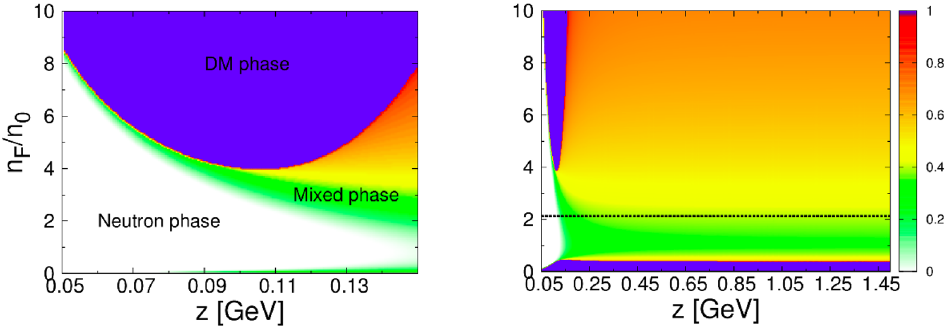
Figure 3 . The three phases of the NS. The right panel shows n F =n 0 for a wider range in z . The shading indicates n (cid:31) =n F for a given n F . For the NS we consider, n F ’ 2 : 125 n 0 , which is indicated by the dashed horizontal line. In this case (cid:31) contributes about 40% of the total number density of the